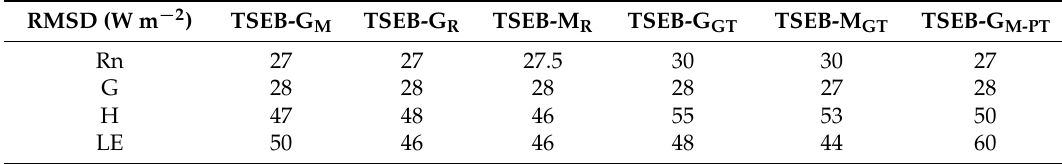
Table 4. RMSD for Rn , G , H and LE from the application of TSEB and the different versions with T RAD derived from the four-way radiometer (ECT).